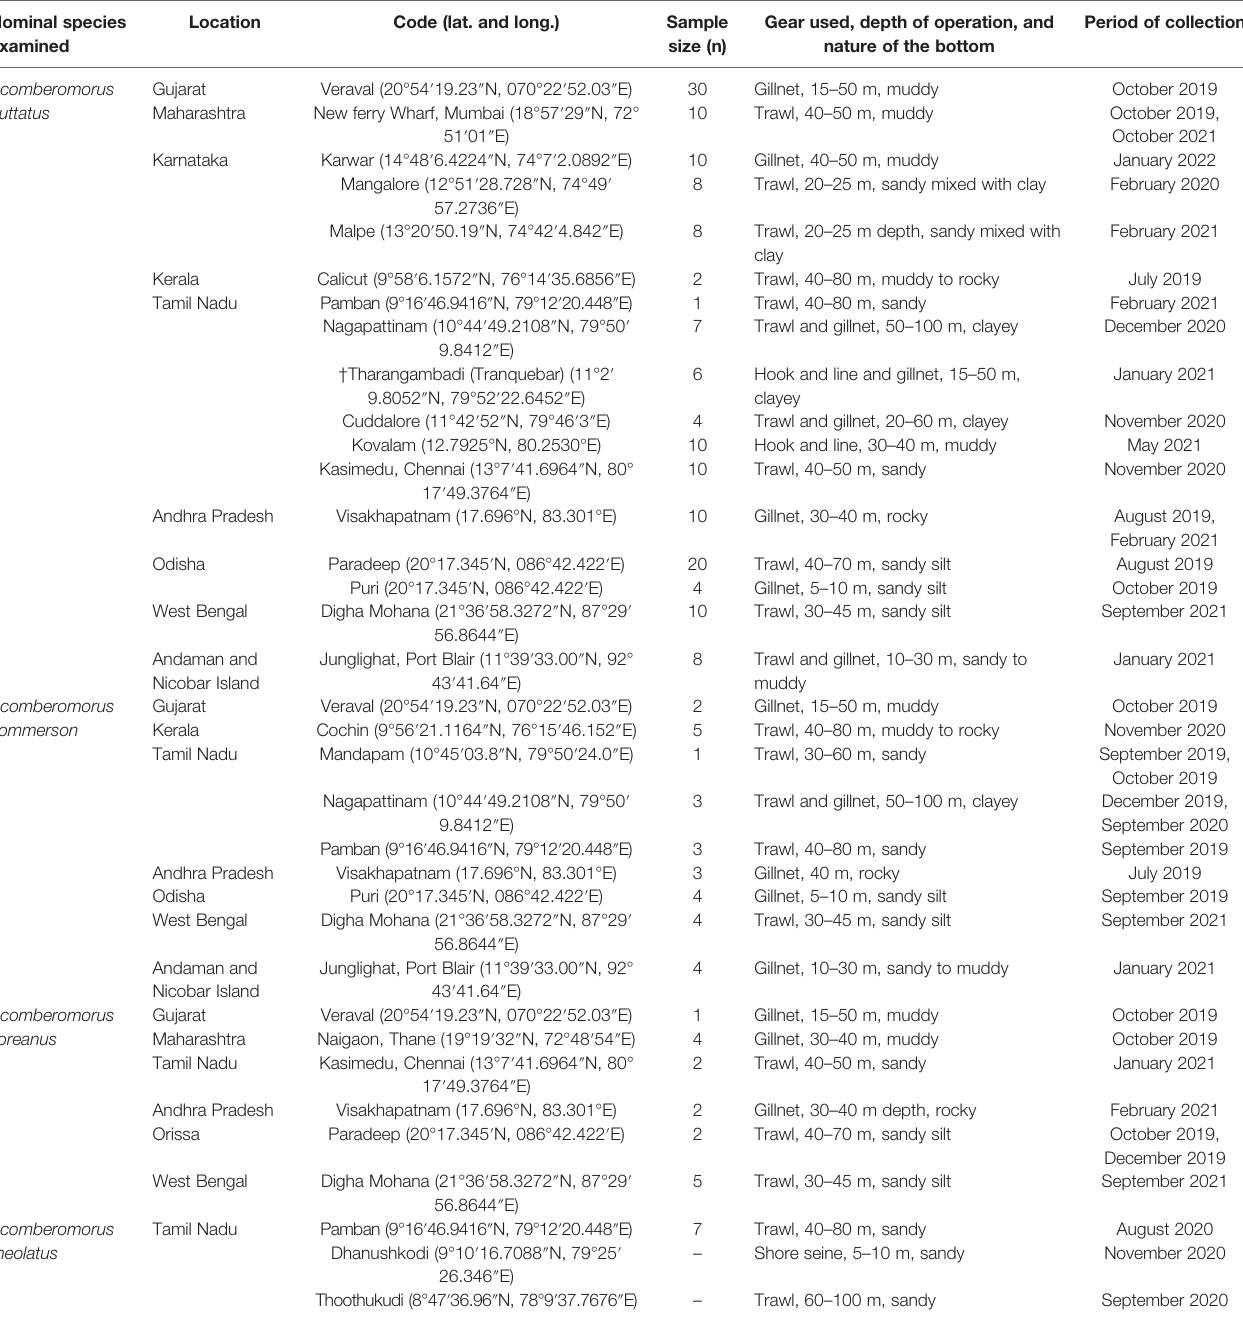
TABLE 2 | Locations of sampling ( fi shing harbors) and fi shery information of Scomberomorus spp. along the Indian coastline including the Andaman Islands. Nominal species Location Code (lat. and examined